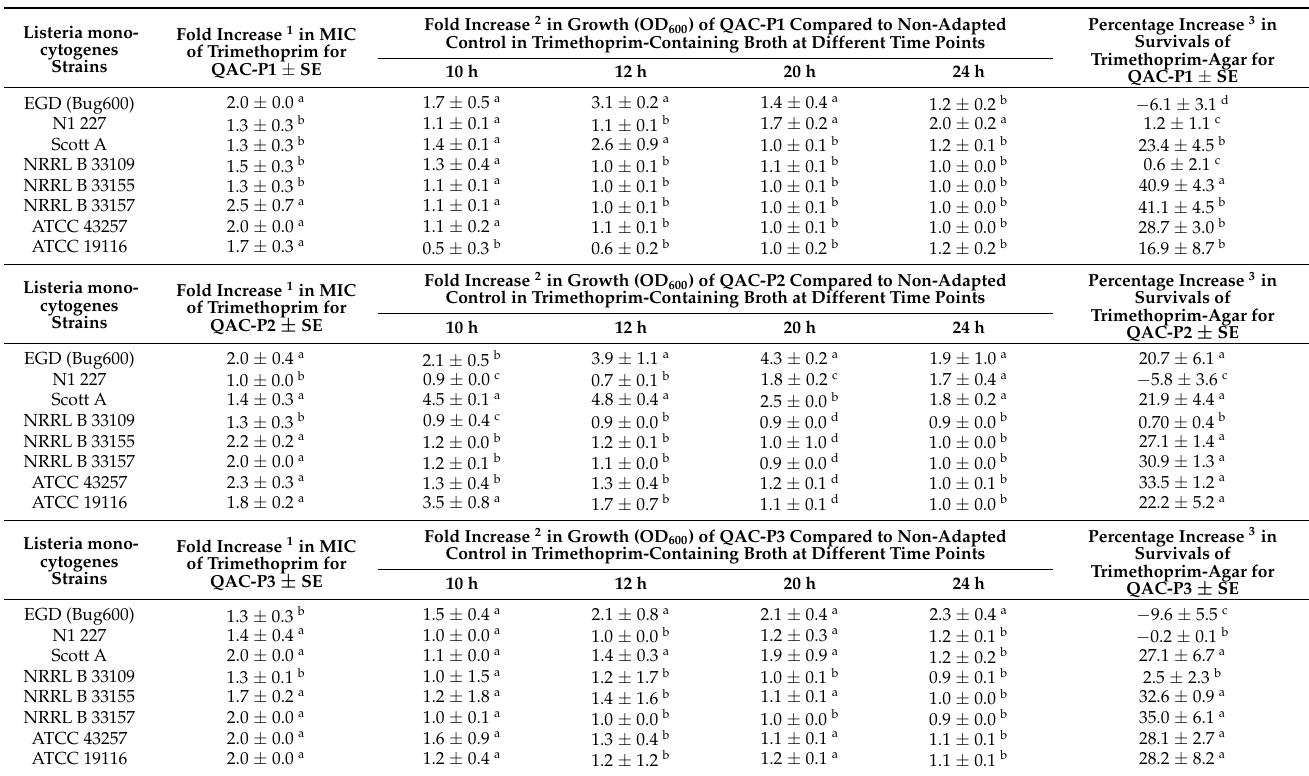
Table 2. Fold increase in MIC of trimethoprim, fold increase in growth rate at different time points (OD 600 ) in trimethoprim- containing broth, and percent increase in survival in trimethoprim-containing agar of three QAC-adapted subpopulations (QAC-P1, QAC-P2, and QAC-P3 compared to non-adapted control (NAc) of eight L. monocytogenes strains. Listeria mono-